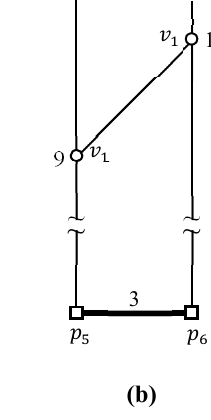
Figure 8. maxdist ( v 1 , { p 4 p 5 , p 5 p 6 } ) = 12 and mindist ( v 1 , { p 4 p 5 , p 5 p 6 } ) = 9: ( a ) maxdist ( v 1 , p 4 p 5 ) = 11 and mindist ( v 1 , p 4 p 5 ) = 9; ( b ) maxdist ( v 1 , p 5 p 6 ) = 12 and mindist ( v 1 , p 5 p 6 ) = 9.